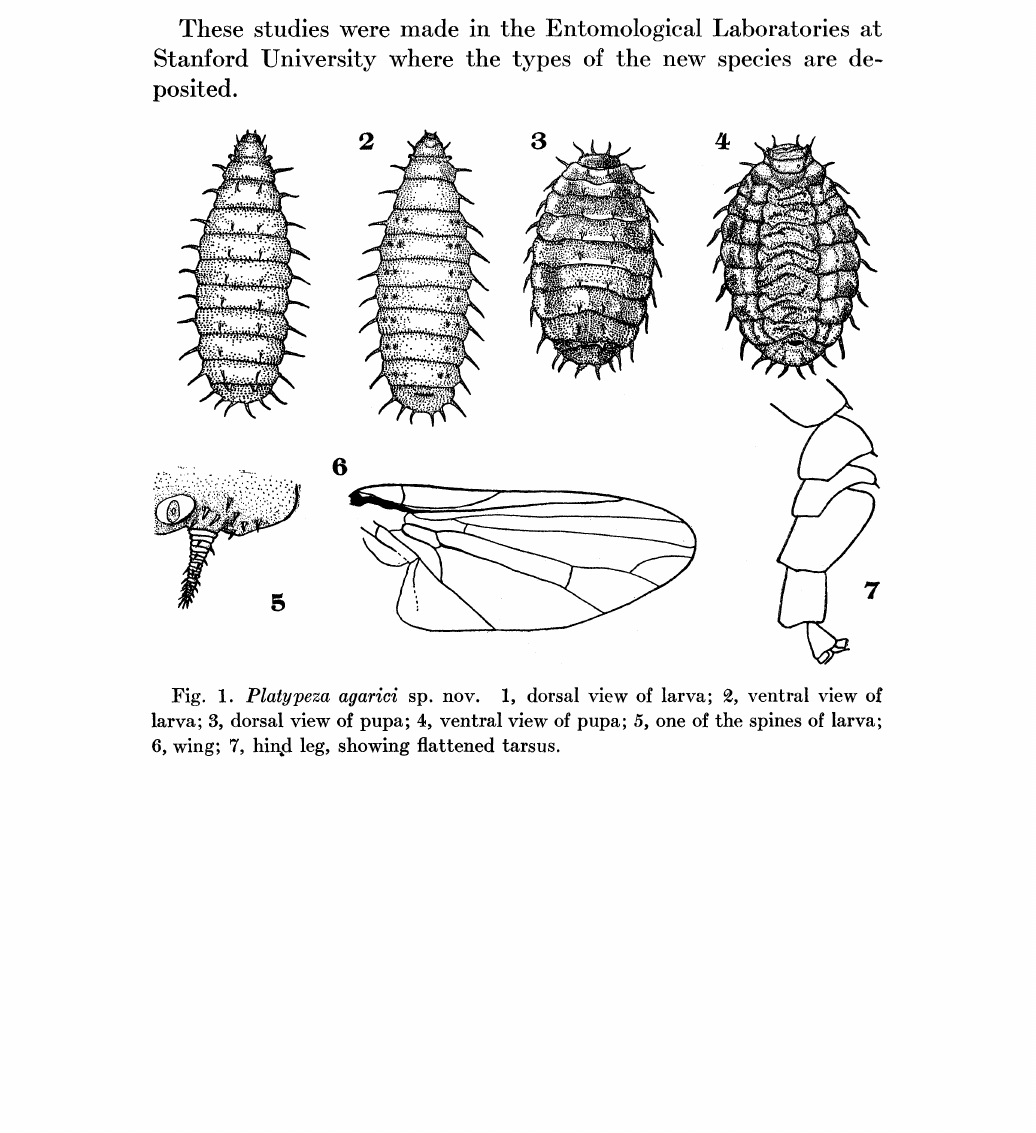
Thorax black with black hairs. Abdomen velvety black; last segment and in- cisures dark gray; sides and back covered with fine, soft, black hairs. Legs fuscous or blackish; hind tarsal joints flattened, the basal segment broadest, the third seg- ment longest; halteres fuscous; knobs black. Wings hyaline, subcostal cell with a very faint yellowish tinge; veins brown; anterior branch of 4th vein rises at al- most a right angle from the fourth vein; posterior branch.does not reach the margin of the wing; second posterior cell very short. The distance from the posterior cross vein to the tip of the 5th vein is about one-third the length of the posterior cross vein. Fetnale: Eyes not contiguous or divided. ’ace grayish. The first, third, fourth, and fifth segments of abdomen